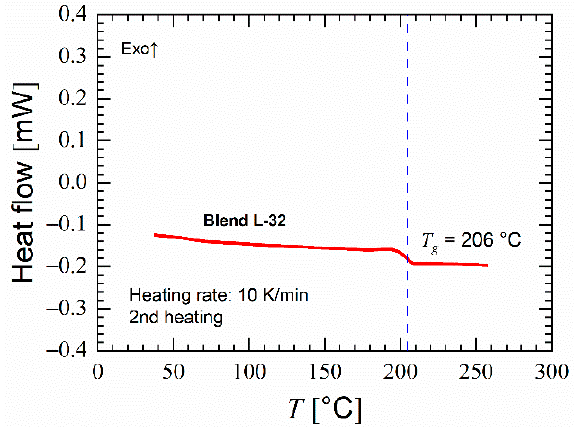
Figure 2. Heat flow versus temperature in second heating of blend L-32 showing single glass transition.